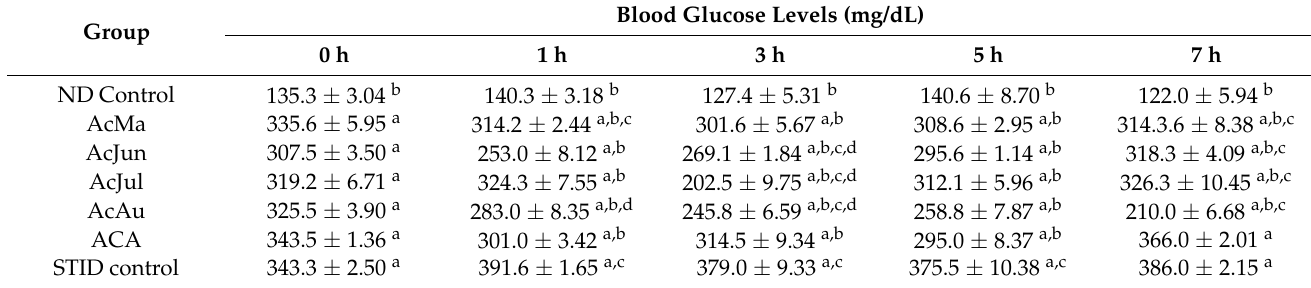
Table 1. Blood glucose levels of streptozocin-induced diabetic (STID) mice and nondiabetic mice (ND) at 0, 1, 3, 5, and 7 h post-administration of IELAc from May (AcMa), June (AcJun), July (AcJul), and August (AcAu).